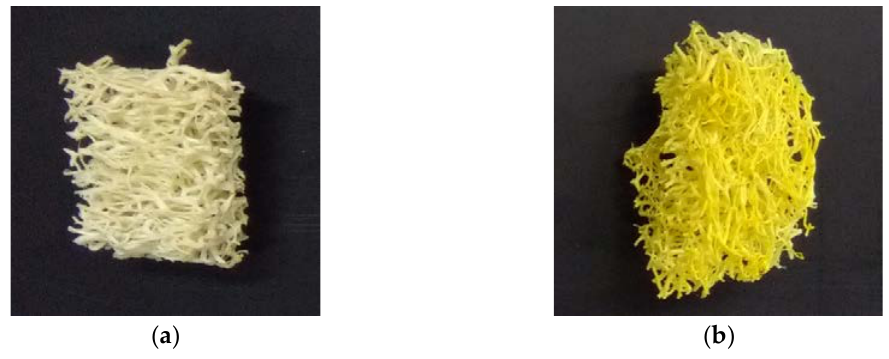
Figure 1. Loofah sponges cubes after total enzymatic activity assay; ( a ) unimmobilized carrier ( b ) loofah cubes after incubation with Planococcus sp. S5 cells.